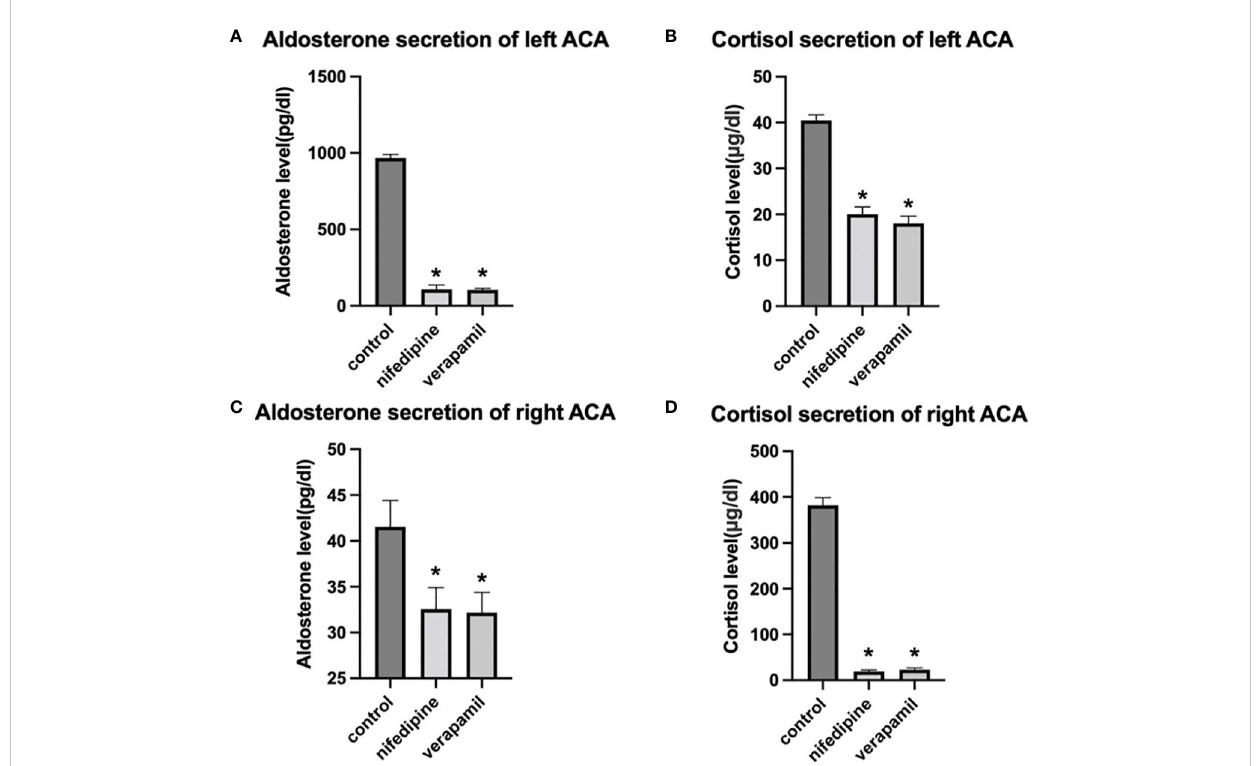
FIGURE 3 Effects of nifedipine and verapamil on aldosterone and cortisol secretions, respectively, in the primary cells of bilateral adenomas. (A, B) Effects of verapamil and nifedipine on the secretion of aldosterone and cortisol in the left adenoma. (C, D) . Effects of verapamil and nifedipine on the secretion of aldosterone and cortisol in right adenoma. * P < 0.05 compared with the control. left ACA, left adrenocortical adenoma of the index patient; right ACA, right adrenocortical adenoma of the index